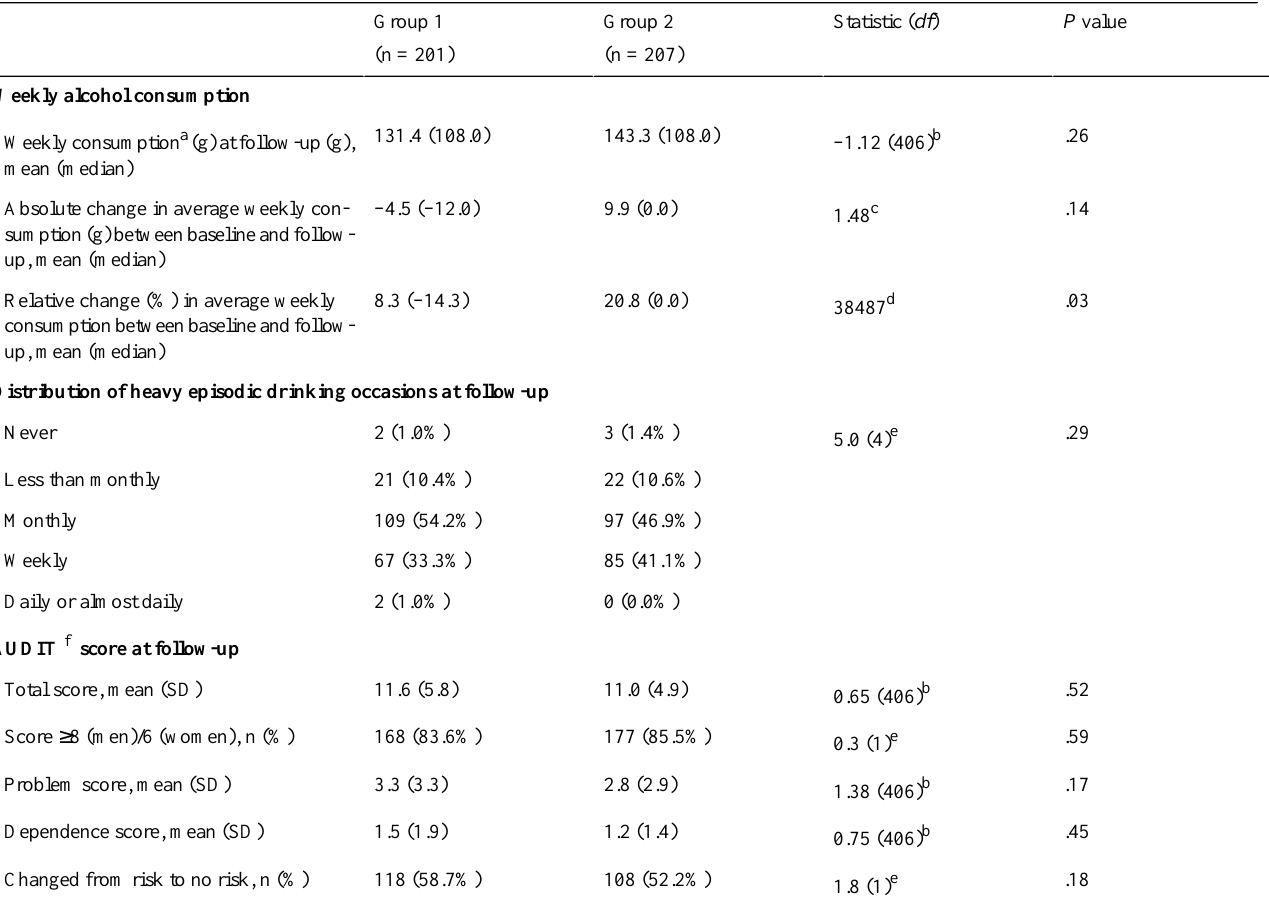
Table 4. Per-protocol analyses of group 1 (assessment and feedback) and group 2 (assessment-only) (n = 408).